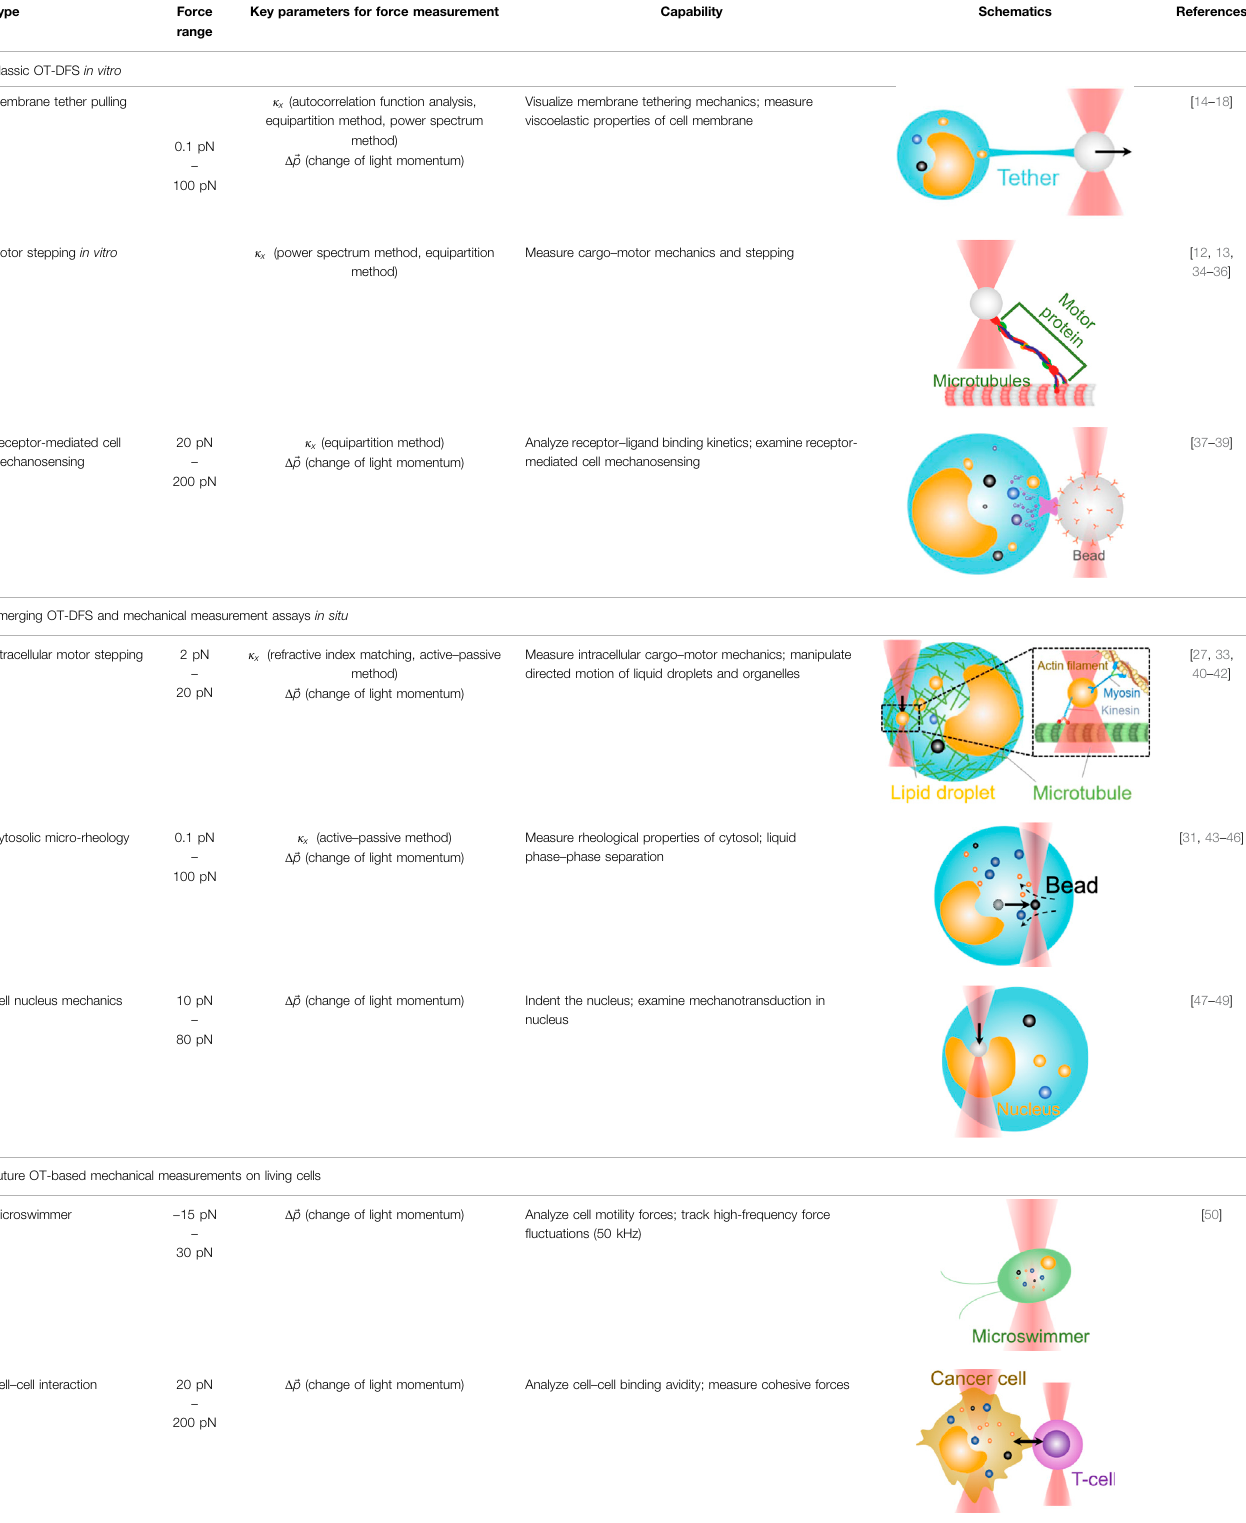
Membrane tether pulling: a bead (gray) is trapped and pulls the tether from the cell (blue); motor stepping in vitro : a motor protein coupled bead (gray) is trapped and binds with the microtubules; receptor-mediated cell mechanosensing:afunctionalizedmicrosphere(yellow)istrappedandadheresthecelltotrackthebead – celladhesionforce;intracellularmotorstepping:amotorproteinattachedlipiddropletistrappedandmovesalongtheactin fi lament(yellow)andmicrotube(green);cytosolicmicro-rheology:anintracellularbead(black)istrappedandusestoquantifytheviscoelasticpropertiesof fl uidinthecell;cellnucleusmechanics:aninternalizedmicrobead(gray)is trappedandindentsthecellularnucleus(yellow);microswimmer:amicroswimmer(green)istrapped,anditsstochasticforcedynamicsisstudied;cell – cellinteraction:acancercell(brown)andaT-cell(purple)aretrappedseparately, and the bonding interactions are